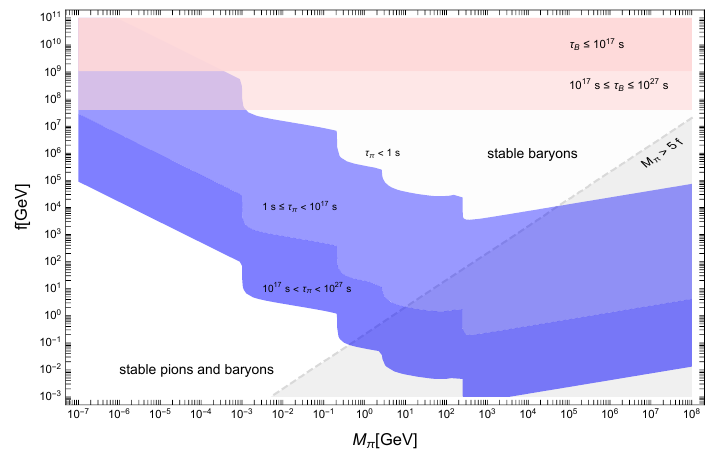
Figure 1. 2-D contours of the life time of dark baryons (pink) and pions (blue) as a function of the pion decay constant f and the pion mass M π , with Λ 5 = M Pl and M B = 10 f . Blue region is excluded if the abundance of pions is comparable to the DM abundance. Massive pions decay through a dimension 5 operator, see text for details.